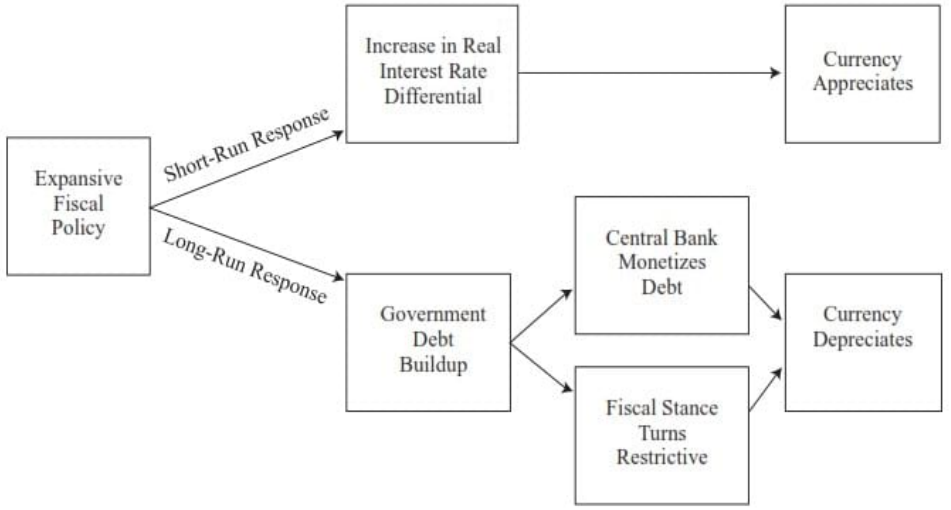
Figure 5. Expansionary fiscal policy and exchange rate.